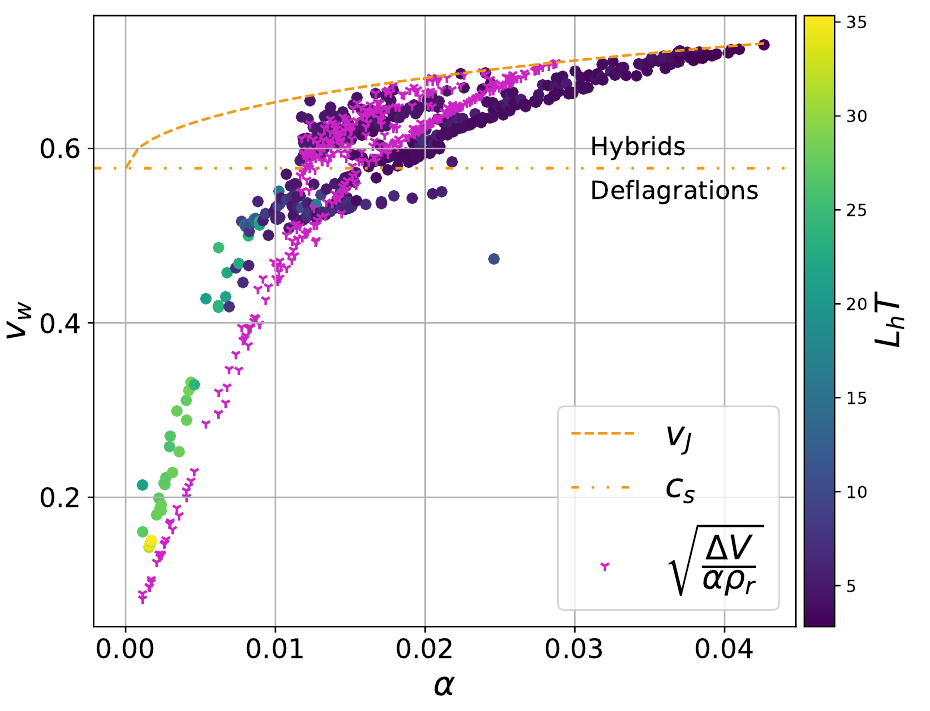
Figure 3 . Predictions for the bubble wall velocity as a function of the strength α of the phase transition. The coloured side-bar gives the value of the Higgs profile thickness normalized to the nucleation temperature. The magenta crosses represent the values of the analytic approximation. The orange dashed and dash-dot-dotted lines represent the Chapman-Jouguet velocity and the speed of sound in the plasma, respectively.